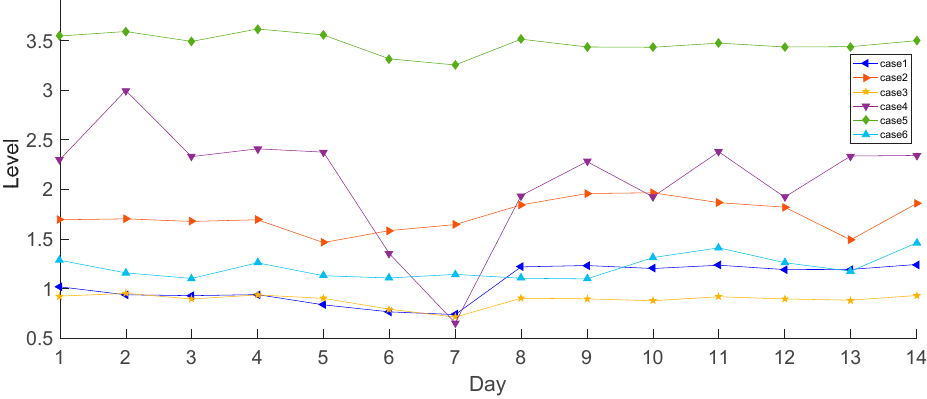
Figure 7. The results of sensitivity analysis.